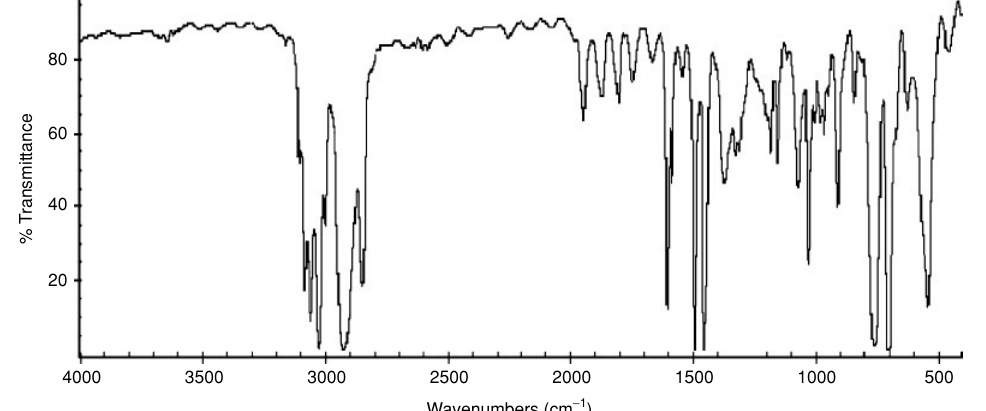
Figure 7 Absorption spectrum of the normalised